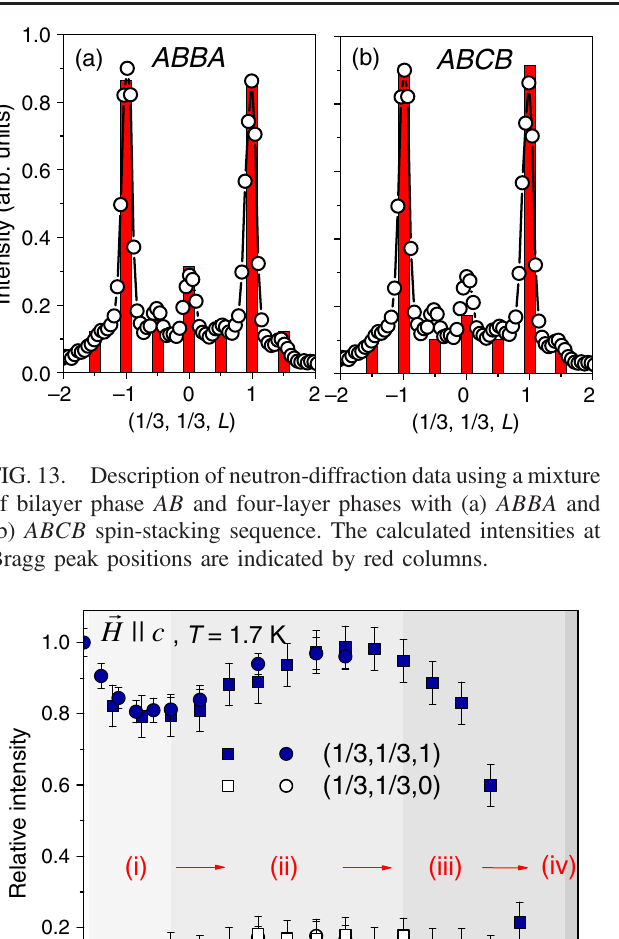
FIG. 14. Field dependence of ð 1 intensities at T ¼ 1 . 7 K and least four intermediate magnetic states between the zero-field ground state and the full magnetization saturation.